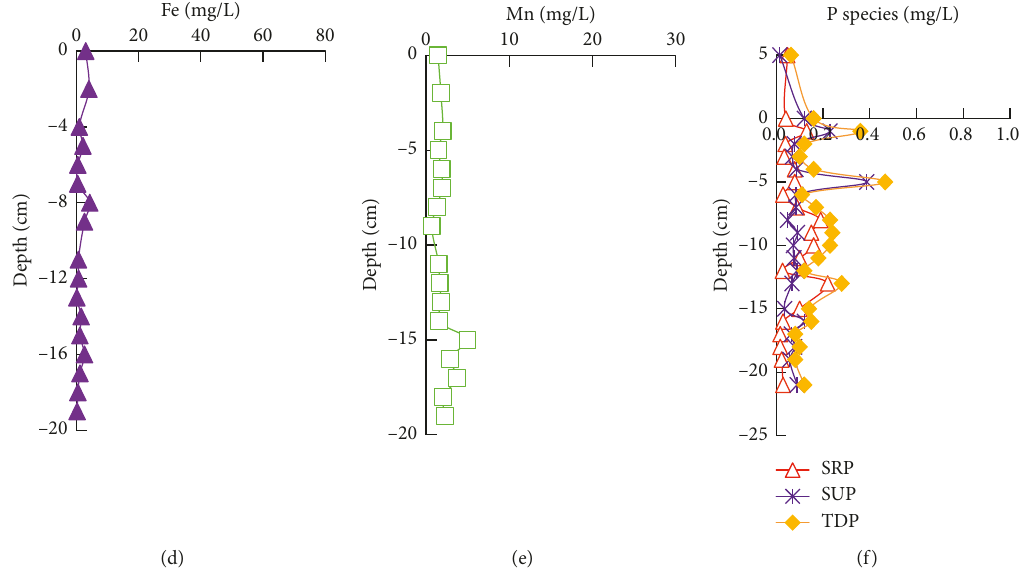
Figure 4: Vertical distributions of dissolved Fe (a), dissolved Mn (b), and phosphorus species (c) in pore waters at the Neijiang site in summer, as well as dissolved Fe (d), dissolved Mn (e), and phosphorus species (f) in pore waters at the Neijiang site in